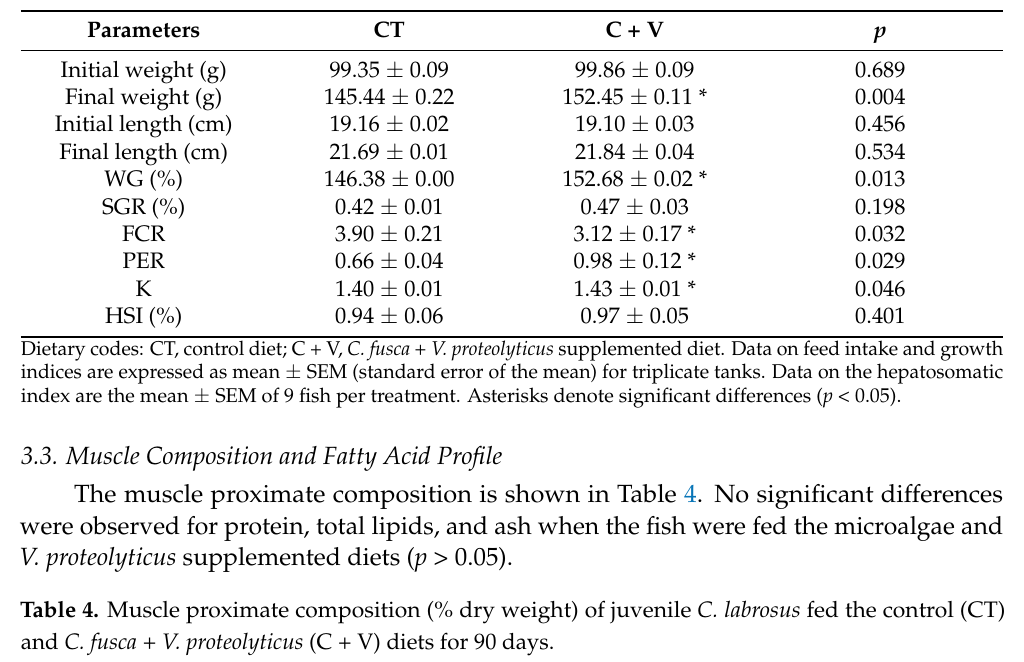
Table 3. Growth performance and somatic indices of juvenile C. labrosus fed the control (CT) and C. fusca + V. proteolyticus (C + V) diets for 90 days.